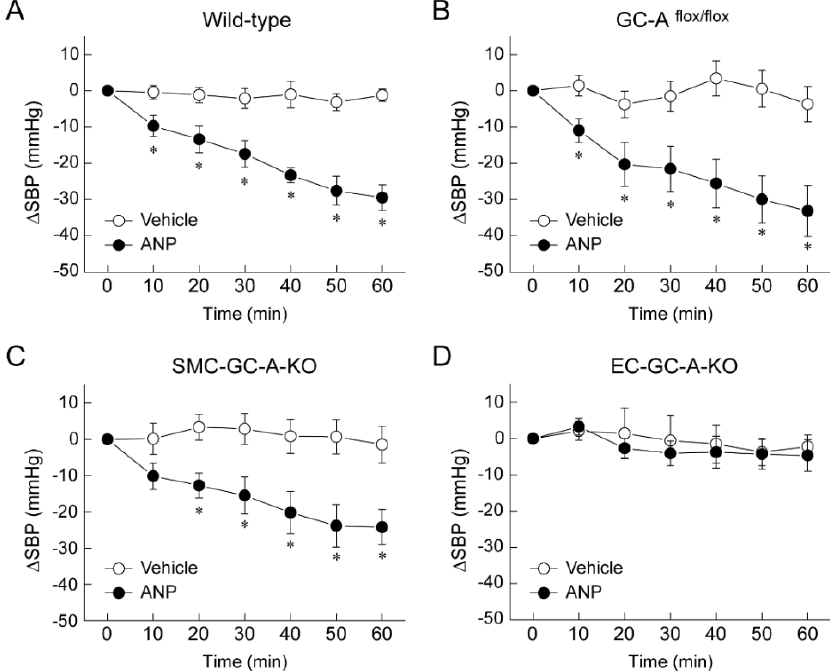
Figure 3. GC ‐ A in vascular endothelial cells contributes to hypotension induced by ANP infusion. Intravenous infusion of ANP (10 μ g/kg/min) significantly lowered systolic blood pressure (SBP) compared with the administration of vehicle (saline) in wild ‐ type mice ( A ), GC ‐ A floxed mice (GC ‐ A flox/flox ), ( B ), and smooth ‐ muscle ‐ cell ‐ specific GC ‐ A knockout mice (SMC ‐ GC ‐ A ‐ KO), ( C ), but not in endothelial ‐ cell ‐ specific GC ‐ A knockout mice (EC ‐ GC ‐ A ‐ KO), ( D ). * p < 0.05 vs. vehicle. This figure is a reconstruction of the figure from our original article [37].